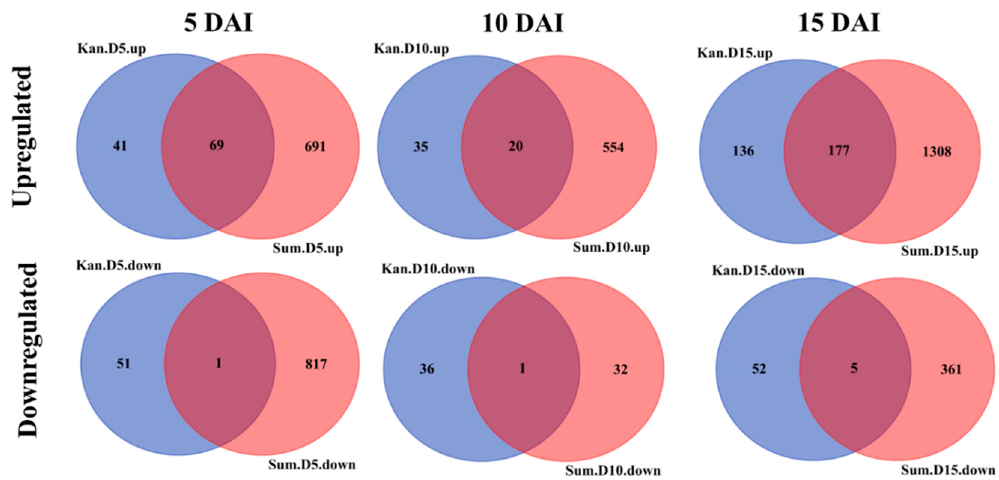
Figure 5. Global changes in DEGs across cultivars for each time point . The Venn Diagrams are represented for each time point between the two cultivars: Kanlow (blue), Summer (red).